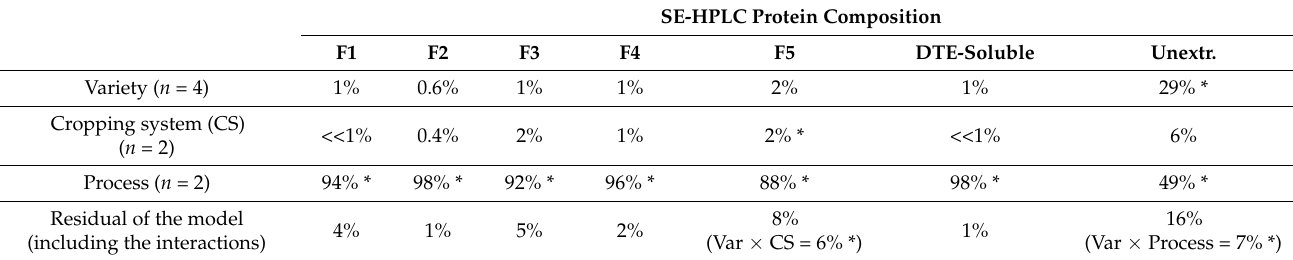
Table 9. Contribution of each factor to the variability of the protein fractions in dry pasta, calculated by the ratio: Sum of squares of the factor/total sum of squares of the